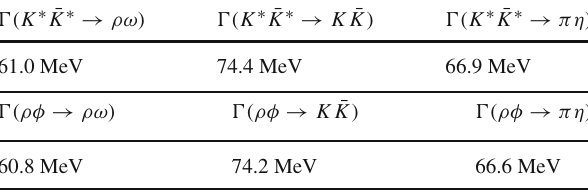
Table 4 The partial decay